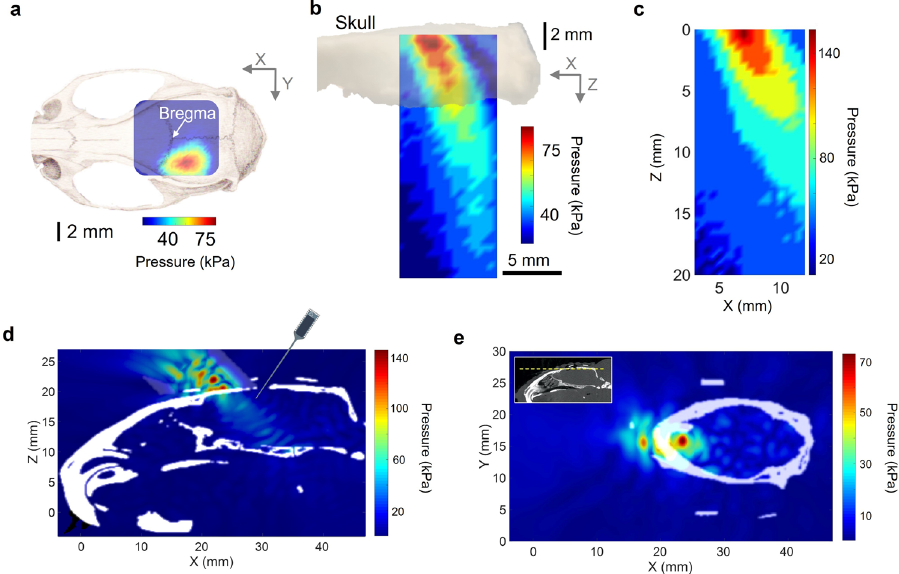
Fig. 2 The characterizations of the tFUS pressure fi elds. a , b One transverse (X – Y plane) and one sagittal (X – Z plane) scans of ultrasound pressure distribution under the cranium using a hydrophone-based US fi eld mapping system. After penetrating through the ex vivo skull top, spatial-peak ultrasound pressure is measured as 79 kPa. The ultrasound intensities are listed in Tables 1 and 2. c A sagittal (X – Z plane) view of ultrasound pressure distribution in the free water without the cranial bone. The ultrasound setup, including the use of collimator and incidence angle, were the same as depicted in Fig. 1a. The spatial-peak ultrasound pressure is measured as 148 kPa. d A 3D computer simulation investigating the quantitative maximum pressure distribution at one sagittal i.e., X – Z plane inside the rat skull (in white) when the tFUS is guided by a 3D-printed collimator (see Methods) and directed to the S1 with an incidence angle of 40°. As illustrated, the intracranial electrode array is inserted into the brain via the cranial burr hole. e A transverse (X – Y plane) view of computer simulated ultrasound pressure fi eld. The yellow dashed line shown in the inset indicates the location of the presented transverse